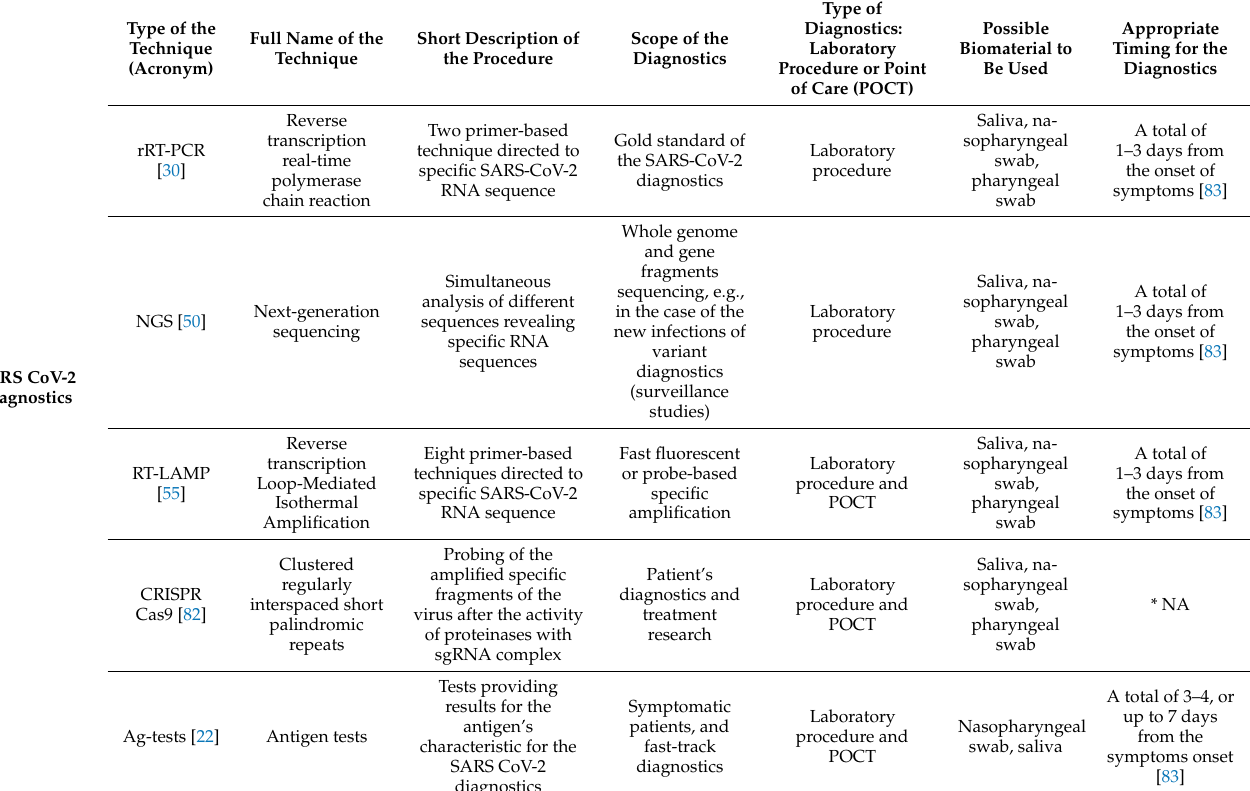
Table 4. Short description of mostly used techniques in the SARS CoV-2